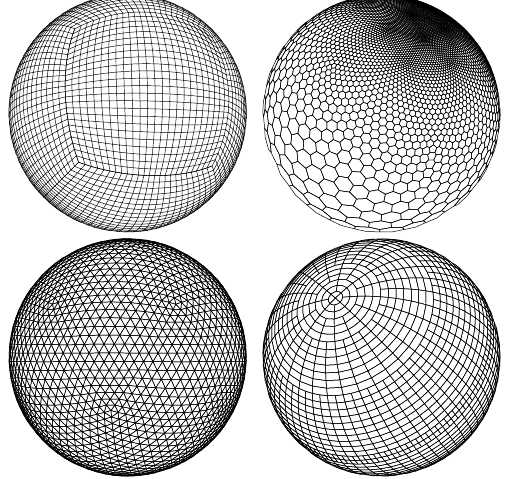
Figure 4. Different meshes are supported and have been tested: latitude–longitude, reduced latitude–longitude (bottom right), trian- gular (bottom left), cubed sphere (top left) and variable-resolution polygonal (top